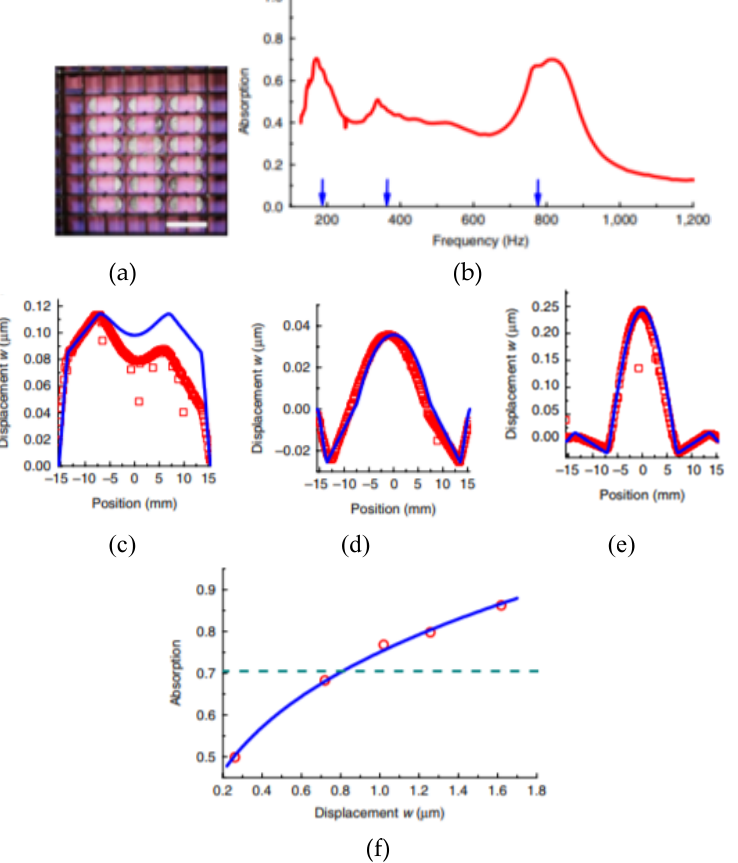
Figure 24. ( a ) Film structure diagram with a semi-circular metal sheet; ( b ) Broadband sound absorption diagram; ( c –e) Sound absorption spectra at 172 Hz, 340 Hz, 813 Hz and displacement relationship of the film system; ( f ) Graph of sound absorption and displacement [80].